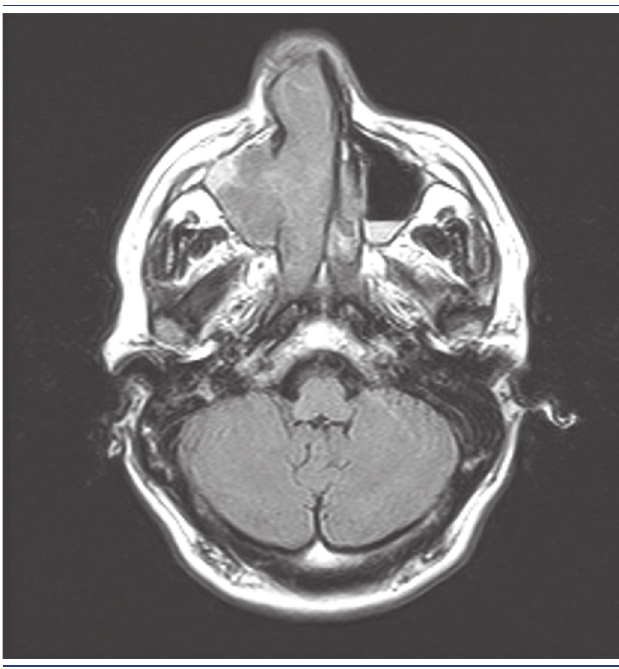
figurE 3 − Photomicrographs presenting tumoral cellularity in A, syncytial cells with round or elongated nuclei, with hyalinization foci (arrows) (HE stain, magnification 200×); in B, respiratory-type mucosa (*) with dilation of vessels, submucosal edema and increased cellularity of stroma (+) (HE staining, magnification 50×) HE: hematoxylin and eosin.